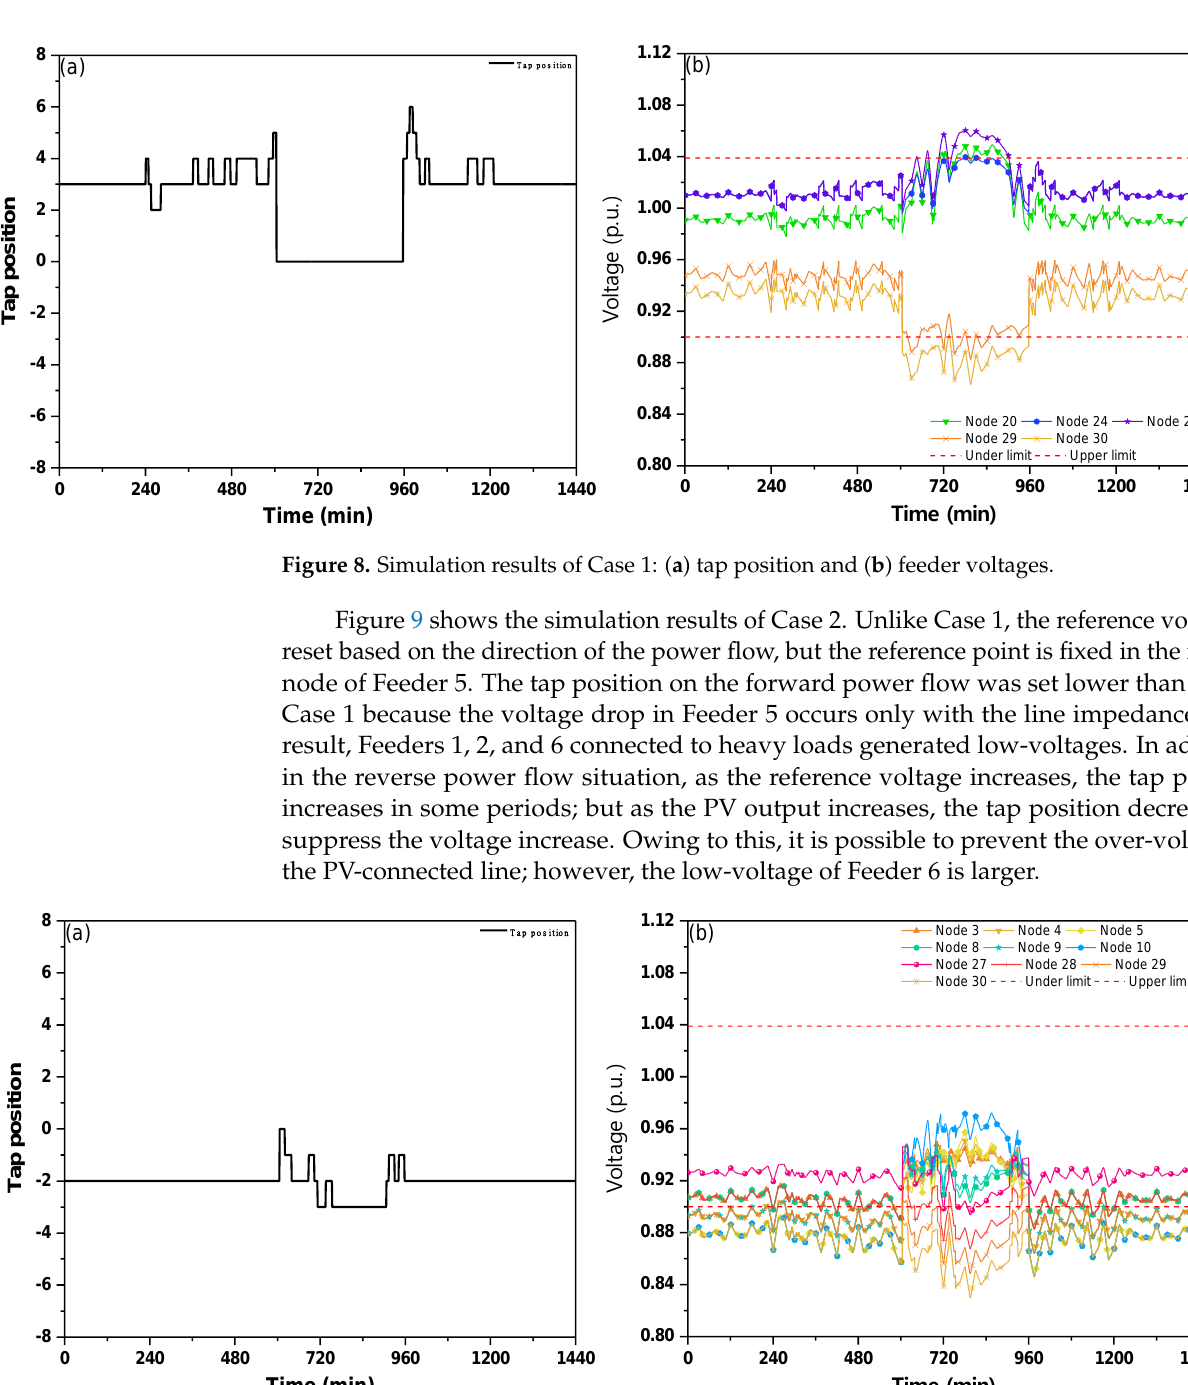
Figure 9. Simulation results of Case 2: ( a ) tap position and ( b ) feeder voltages.